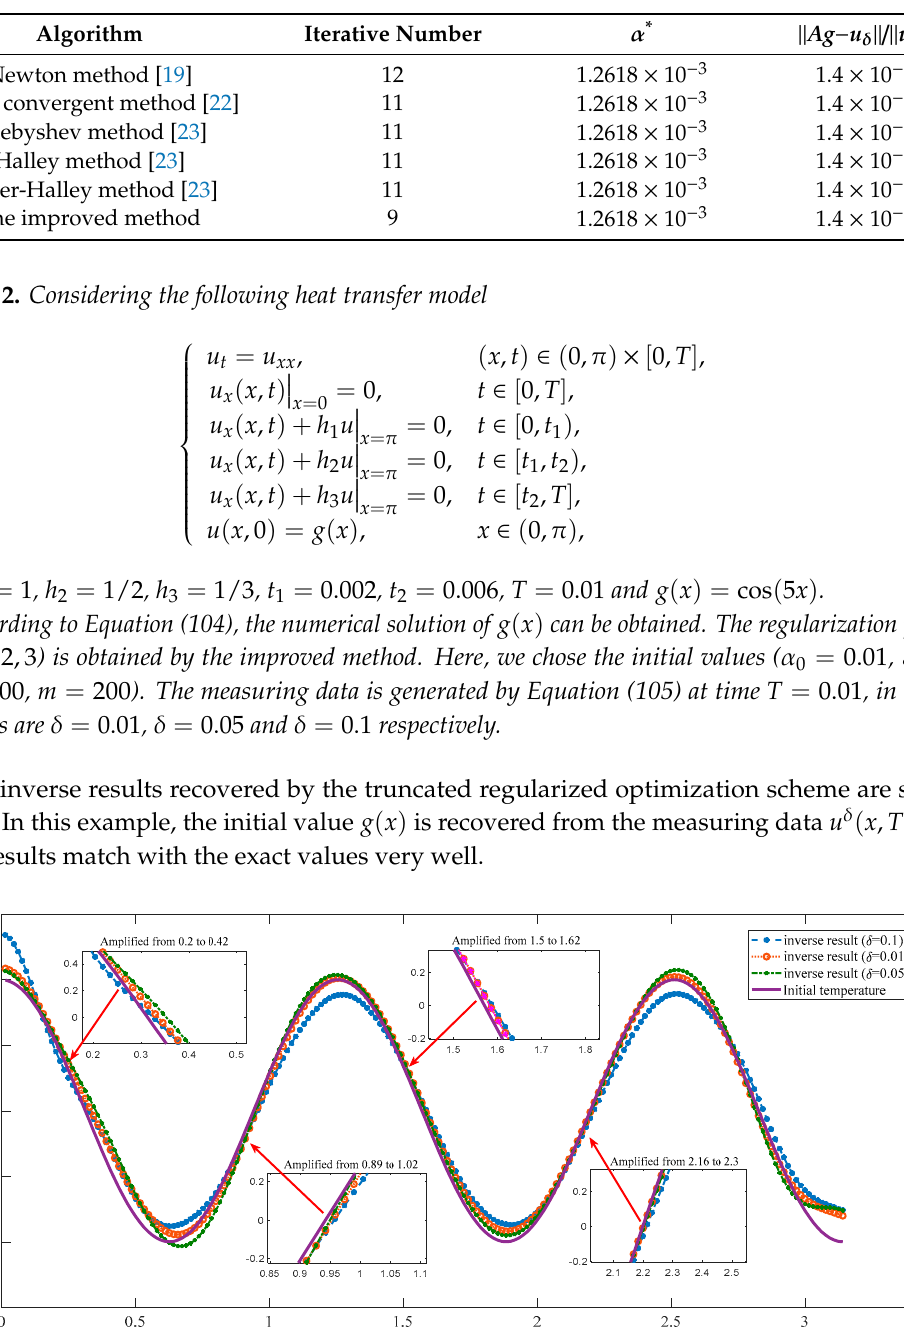
Table 2. The comparison of the improved method with other methods ( α 0 = 0.01, δ = 0.005).